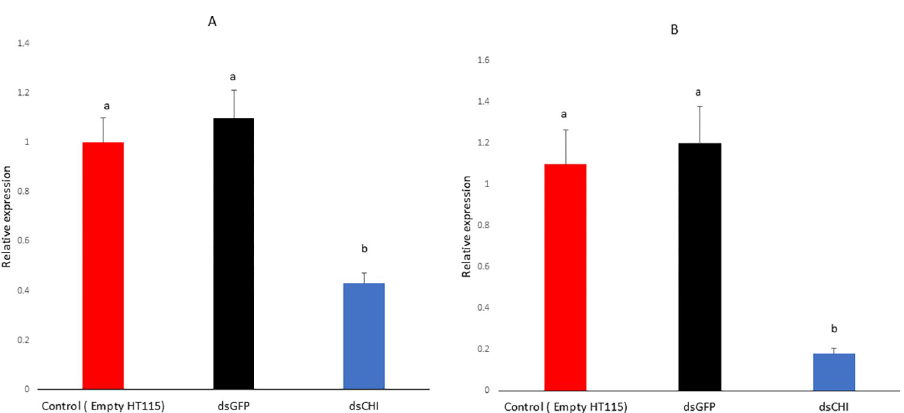
Fig 5. Relative knockdown in transcript levels of chitinase gene during in-vitro feeding assay with bacterially expressed dsCHI after (A) period of 5 days post-exposure. (B) period of 15 days post-exposure. Values are expression mean ± standard error and different letters indicate significant different (p < 0.05) between dsCHI gene and the controls (Empty HT115 and dsGFP ).